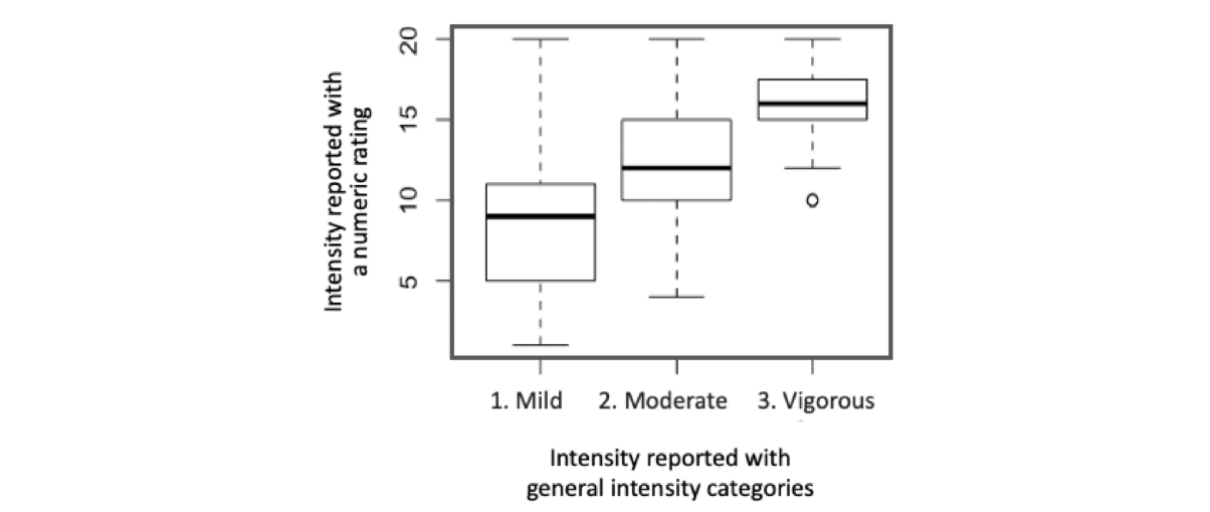
Figure 2. The distribution of numeric intensity rating reported for the general intensity